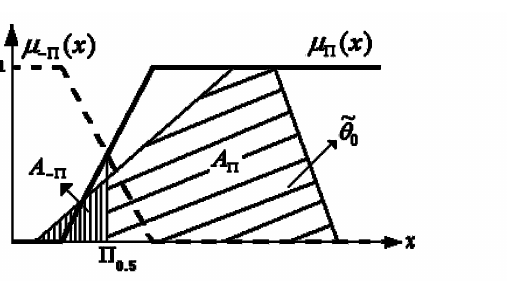
Fig. 9. A Π and A